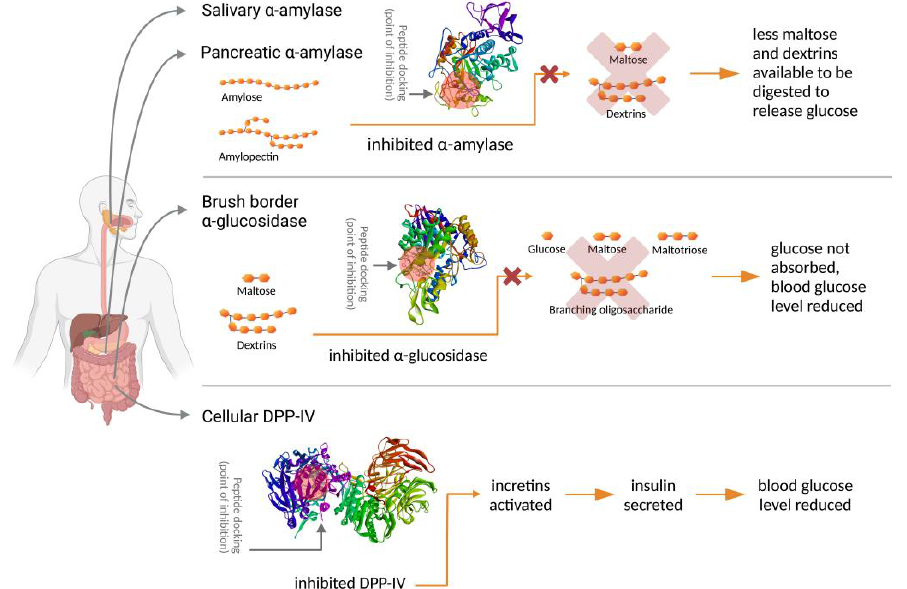
Figure 1. Inhibition mechanisms of α -amylase, α -glucosidase, and DPP-IV by peptides in controlling diabetes (Created with